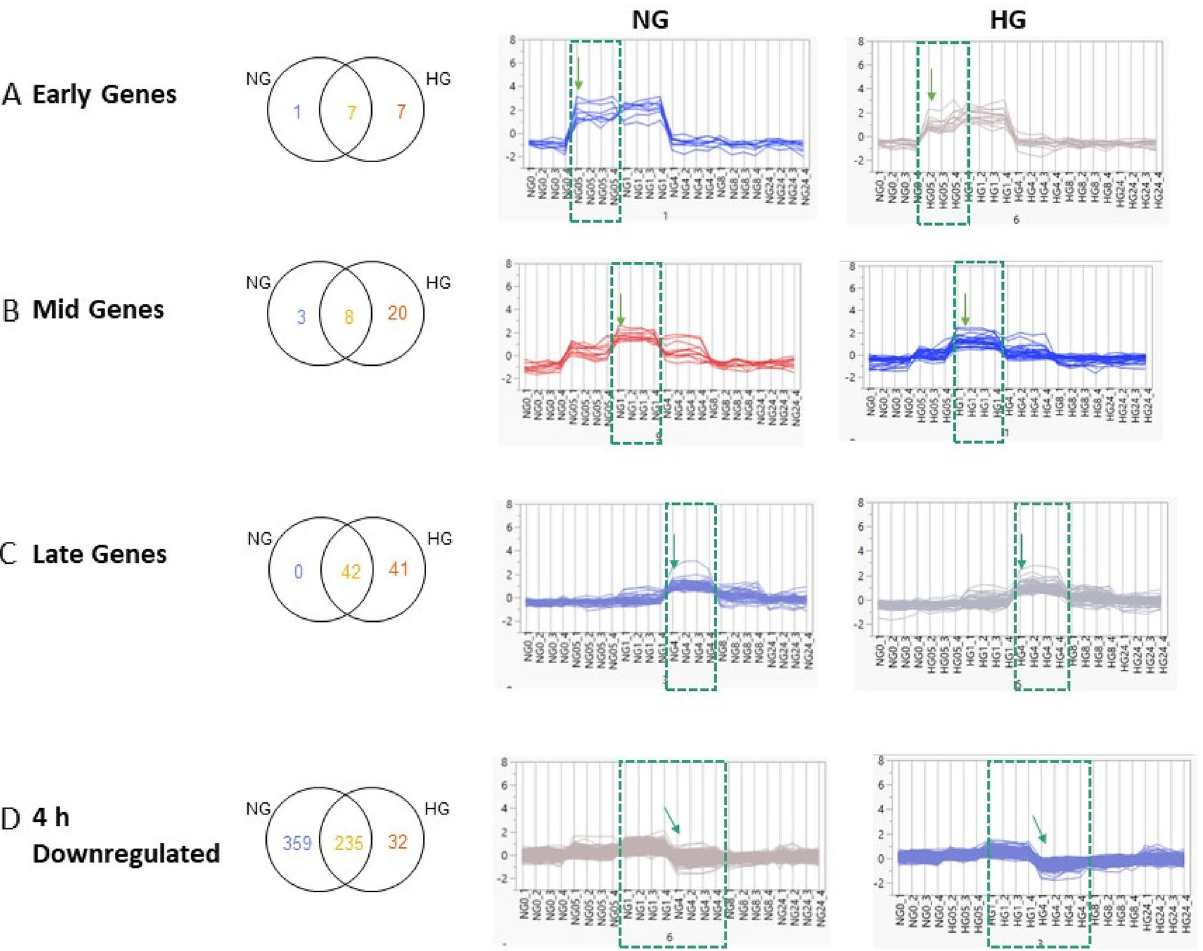
Figure 5. K-means clustering of DEGs in NG and HG conditions. Venn analysis and the expression profiles from K-means clustering of DEGs (± 1.2 fold change, adjusted p-value < 0.05 for significance) in both NG and HG conditions are shown. DEGs from the following pairwise comparisons were analysed for ( A ) early genes, 0 h vs 0.5 h NG/HG, ( B ) mid genes, 0 h vs 1 h NG/HG, ( C ) late genes, 0 h vs 4 h NG/HG ( D ) 4 h downregulated genes, 1 h vs 4 h NG/HG. Green dashed box and arrow highlights the timing of peak expression or switch to